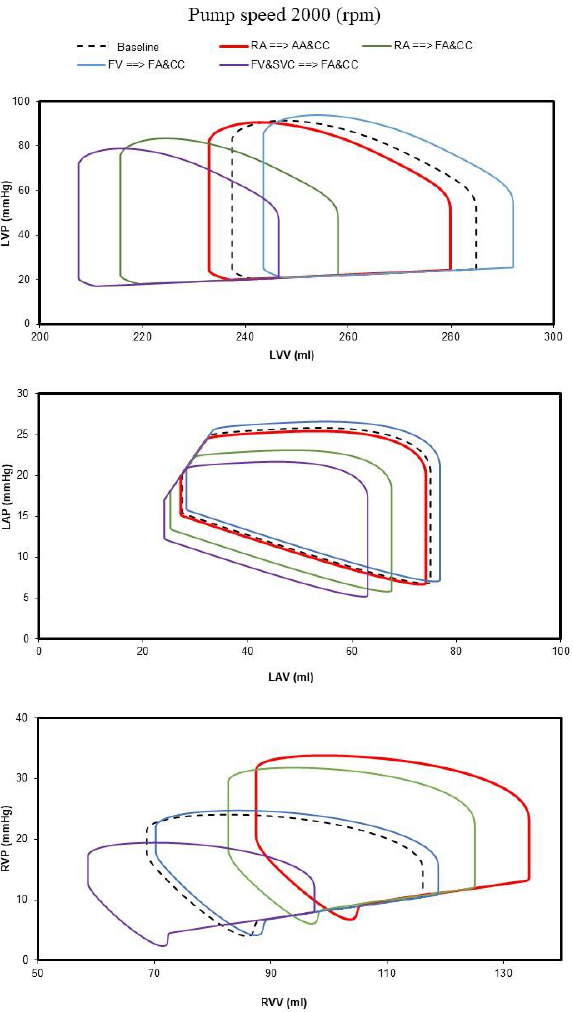
Figure 4. The top ( middle ) panel shows the left ventricular (atrial) pressure–volume loop obtained in baseline conditions and following the four different methods of cannulation when the centrifugal pump speed was set to 2000 rpm. The ( bottom panel ) shows the right ventricular pressure – volume loops. The dashed black loop is obtained in baseline conditions. The red, green, light blue and lilac loops are obtained following RA → AA&CC, RA → FA&CC, FV → FA&CC and FV&SVC → FA&CC connection, respectively.